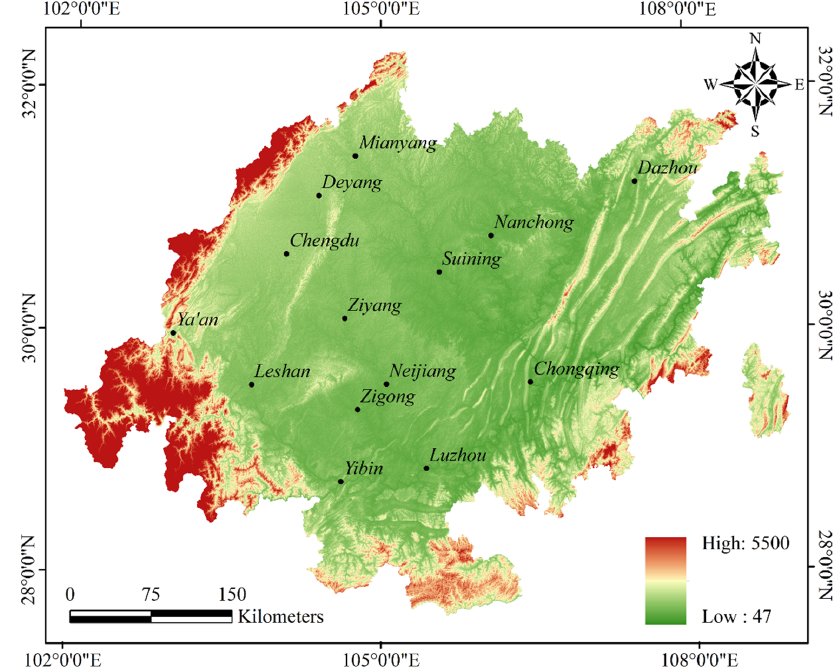
Figure 1. Study area. Land 2022 , 11 , x FOR PEER REVIEW